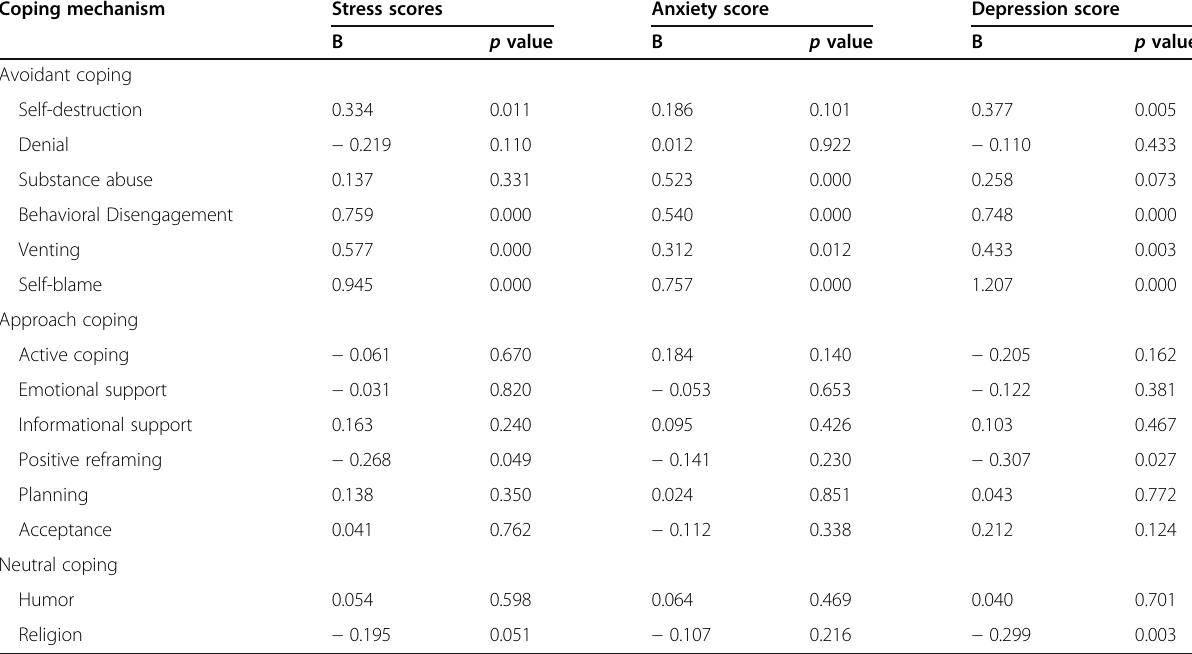
Table 3 Linear regression model comparing stress, anxiety, depression scores with coping mechanisms Coping mechanism Stress scores Anxiety score Depression